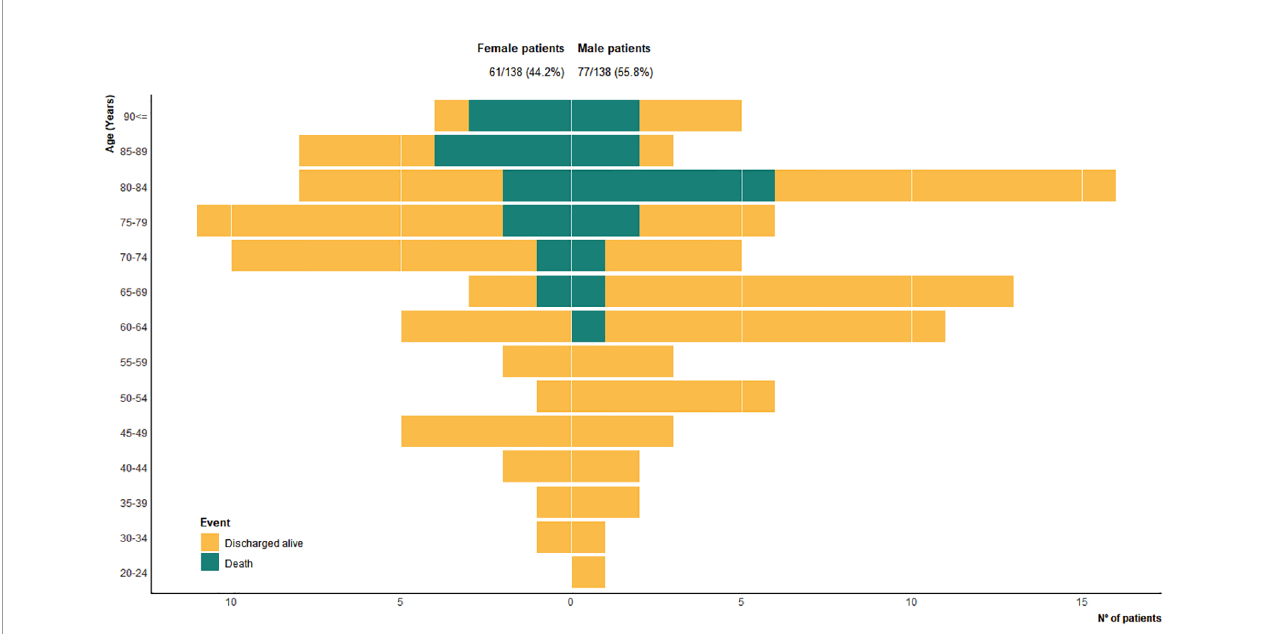
FIGURE 1 | Sex distribution for 138 hospitalized COVID-19 patients in 5-year age groups, according to outcome: discharged; alive; dead. Bar fi lls are